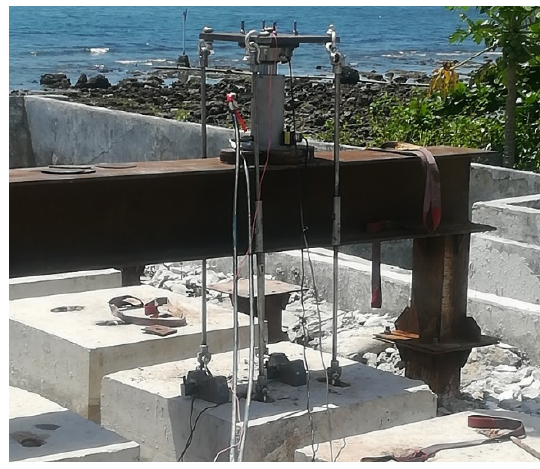
Figure 16. Vertical jack loading of Hg specimen.